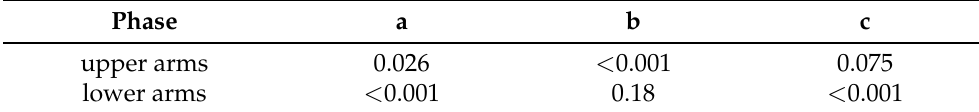
Table 10. Surge current integral ( MA 2 · s ) for D 2 in rectifier with DC